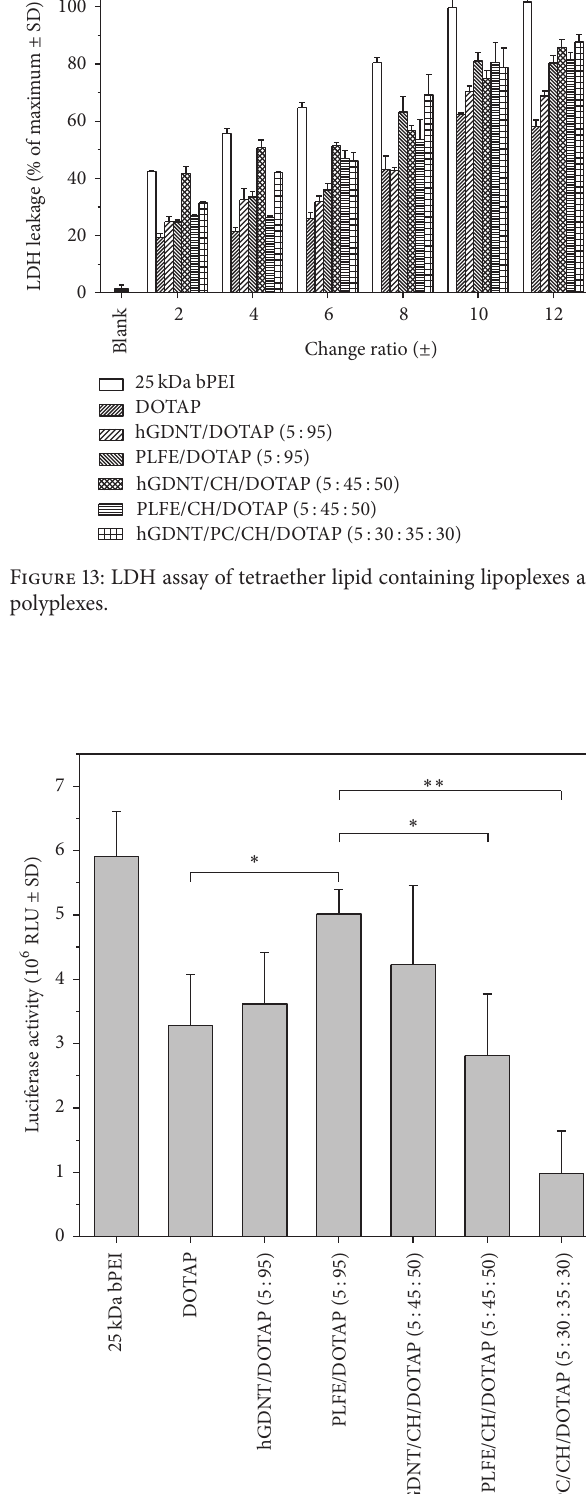
Figure 12: MTT assay of tetraether lipid containing lipoplexes and polyplexes.